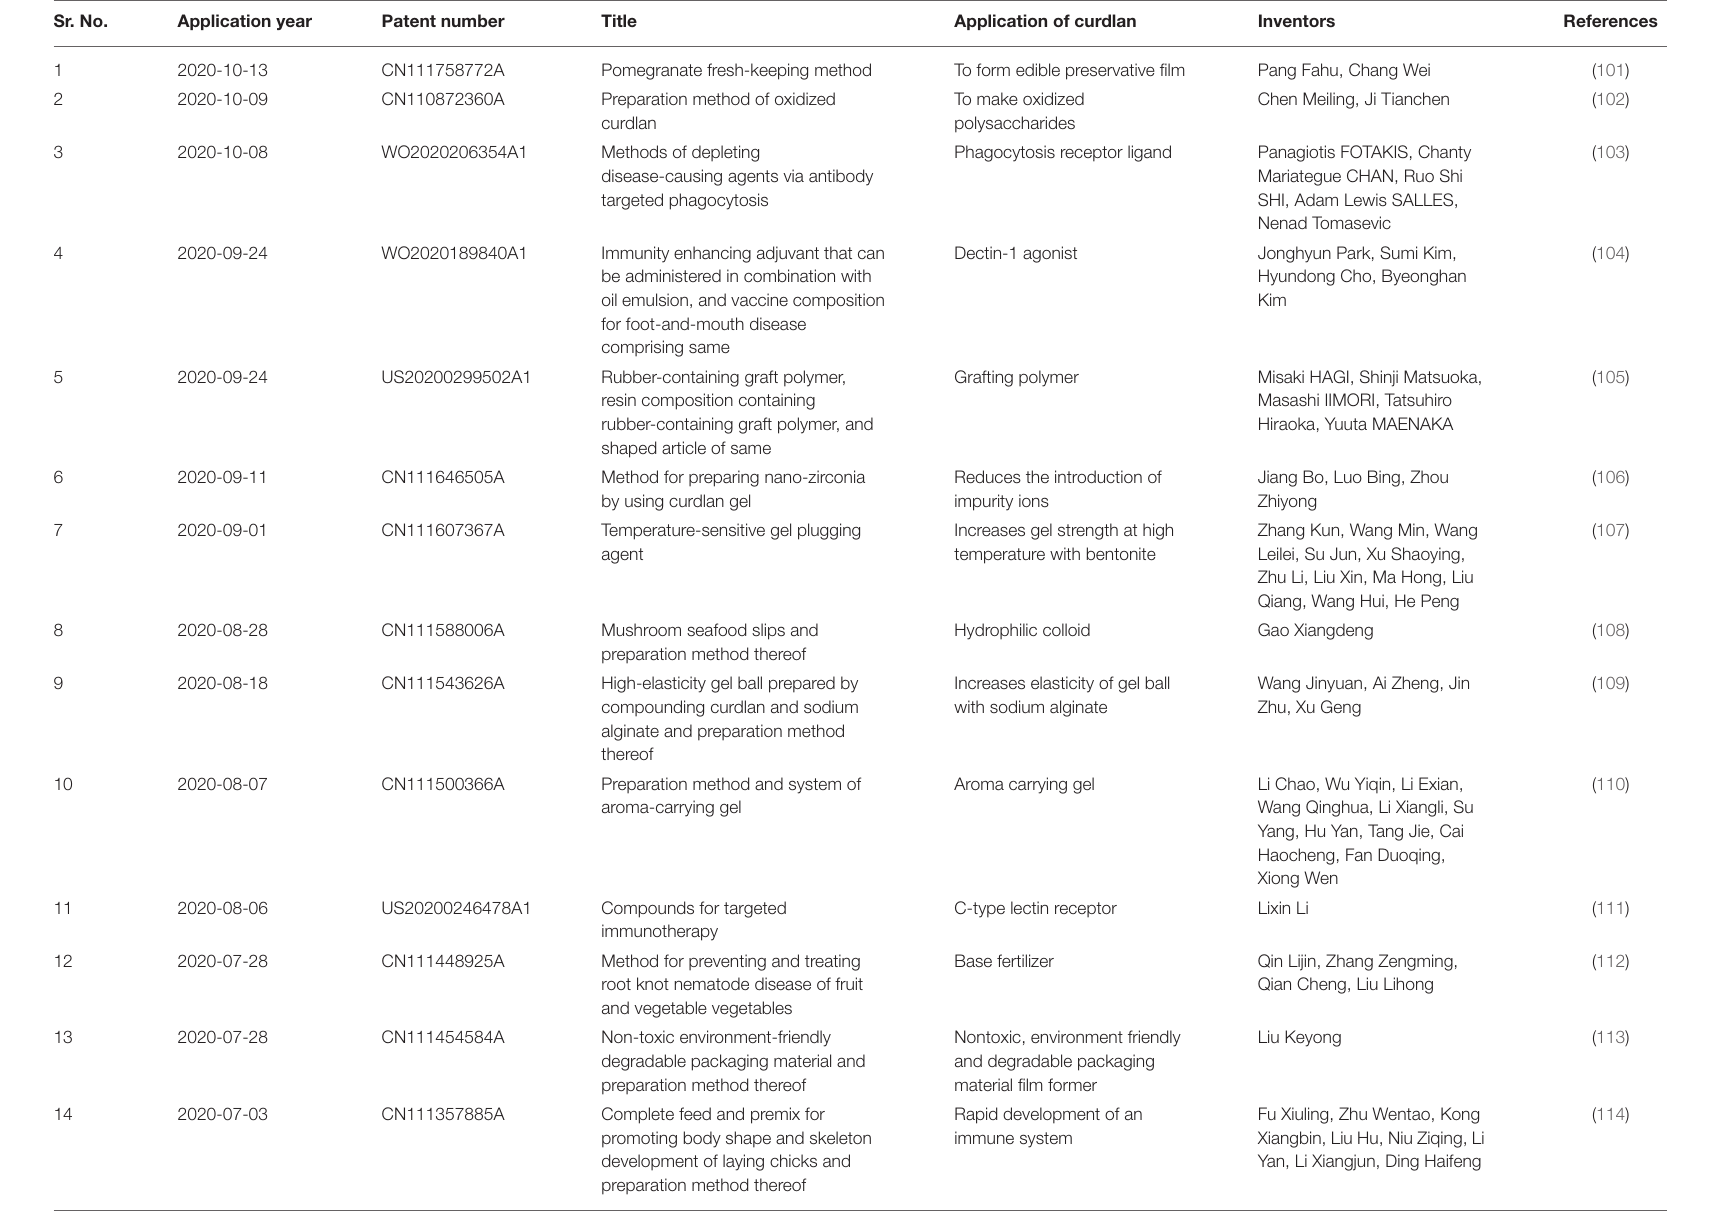
TABLE 4 | Recent patents on curdlan showing patent holders, therapeutic products and a wide array of industrial applications. Sr.